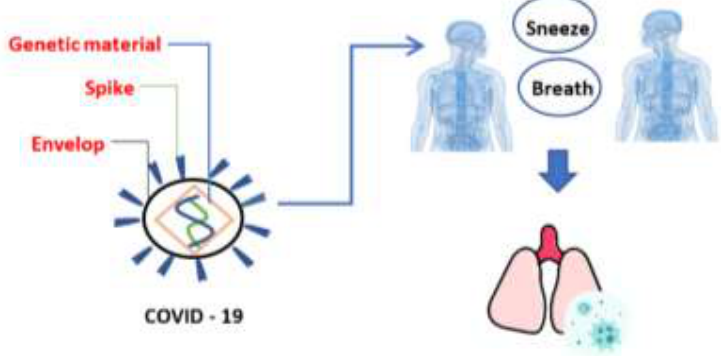
Figure 1. Illustration of a feature shape COVID-19 virus and human transmission